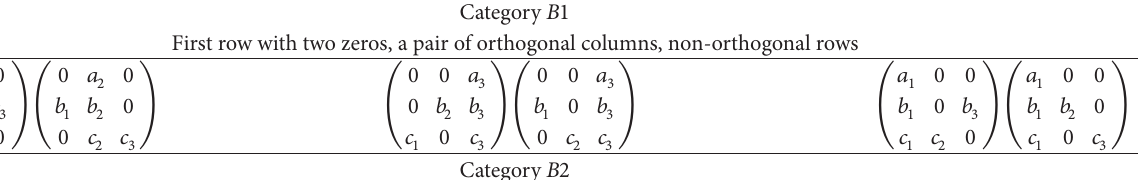
Table 2: Four zero Yukawa textures of 𝑀 𝐷 in Category 𝐵 with subcategories 𝐵1 , 𝐵2 , and 𝐵3 . Category 𝐵1 First row with two zeros, a pair of orthogonal columns, non-orthogonal rows